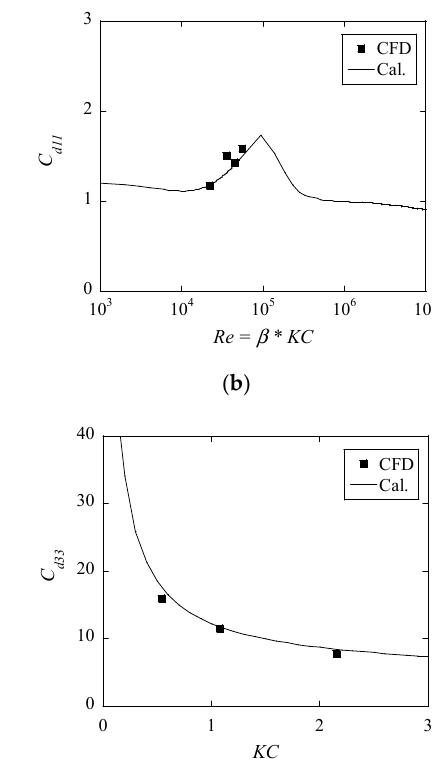
Figure 9. Arrangement of the experiment and layout of the mooring lines in the wave and current conditions.